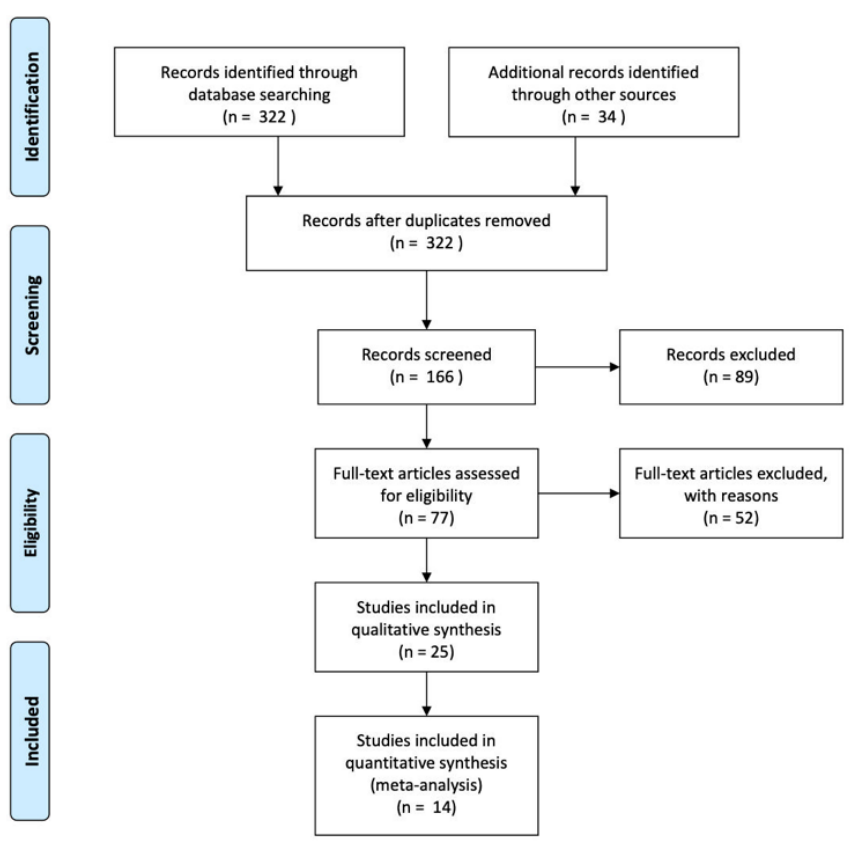
Figure 1. The flow diagram of this